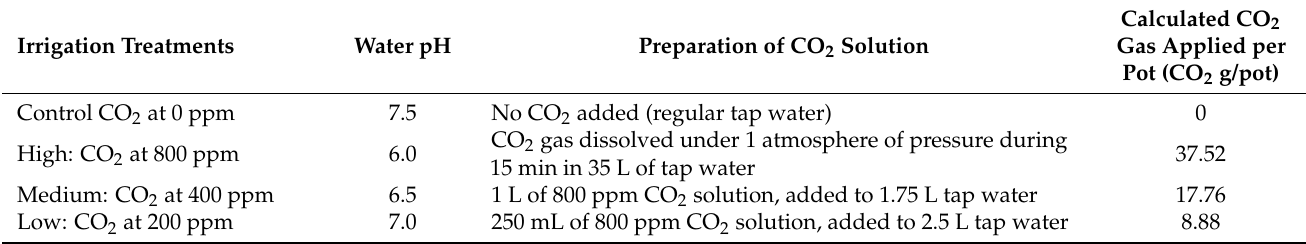
Table 1. CO 2 irrigation levels per pot (g/pot). Barrel soil pots. Irrigation treatment: Control, 200 ppm CO 2 , 400 ppm CO 2 , and 800 ppm CO 2